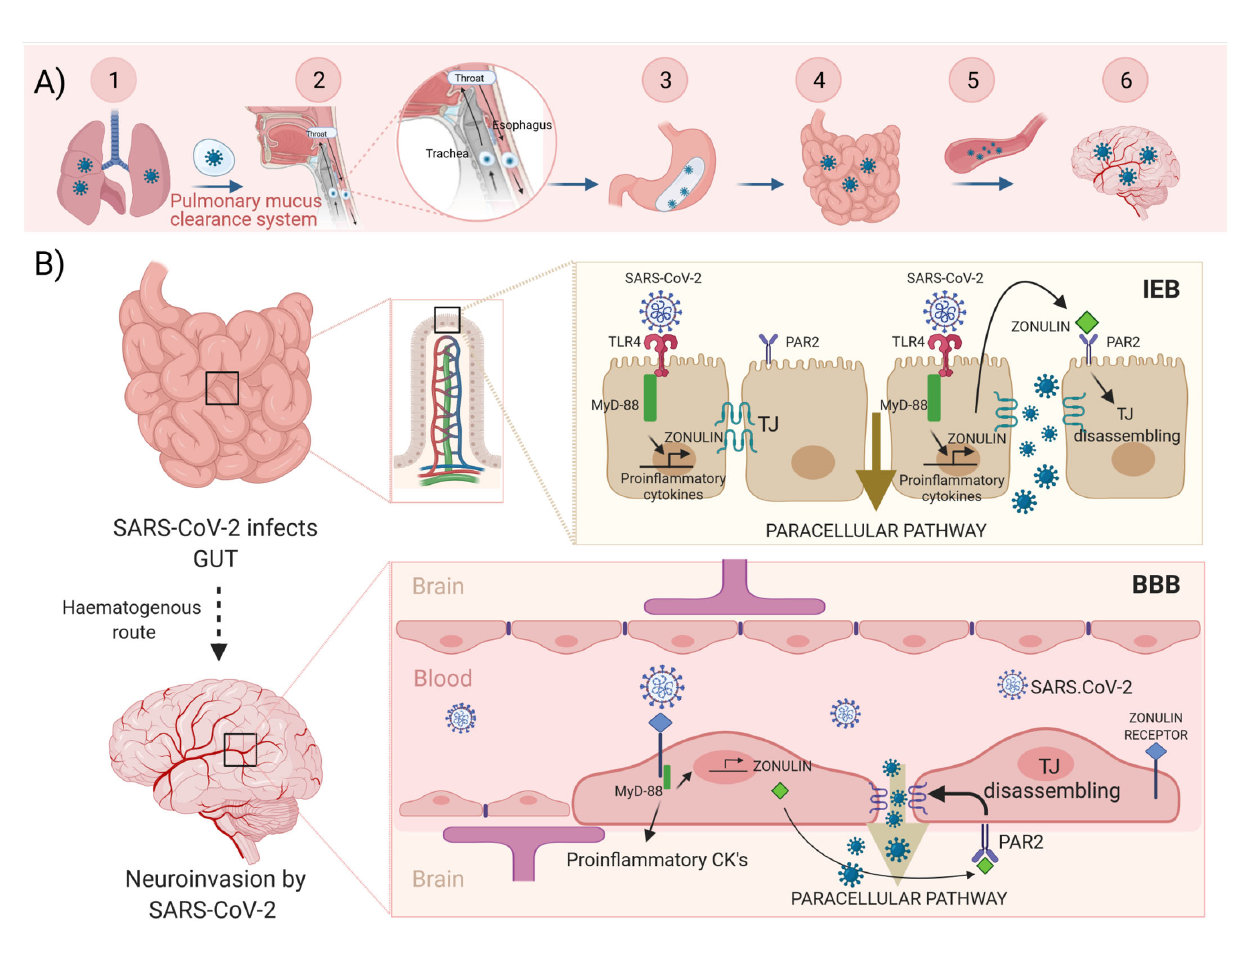
FIGURE 1 | Hypothesis illustrated. Upper panel (A) Scheme of the SARS-CoV-2 journey towards to the brain: 1.-Infected lungs. 2.- The pulmonary mucus clearance system. 3.- Enteroinvasion. 4.- An increased intestinal permeability allows the virus to access the bloodstream and spread. 5.- Haematogenous route. 6.- Neuroinvasion. Lower panel (B) SARS-CoV-2 virus reaches the intestine protected by the mucus from infected lungs. The virus can bind and activate the TLR4, which via MyD-88 could activate both zonulin and proin fl ammatory cytokines expression. Zonulin, secreted to the lumen, binds with PAR2 inducing disassembling of TJ. Now, the virus can use the paracellular pathway to access the circulatory system and reach the brain. Zonulin can also access to the bloodstream. Then, the virus, via brain zonulin receptor, can induce expression of zonulin and consequently increase permeability of the BBB by inducing disassembling of TJ. This causes neuroinvasion of the virus. TLR4, toll-like receptor 4; MyD-88, myeloid differentiation primary response gene 88; PAR2, protease-activated receptor 2; TJ, tight junctions; IEB, intestinal epithelial barrier; BBB, blood-brain barrier. Created with